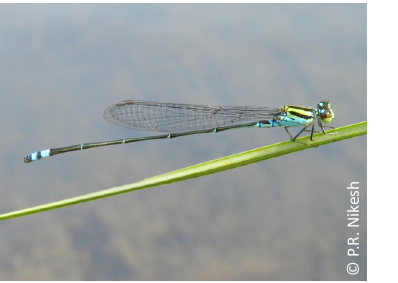
Image 13. Pseudagrion indicum